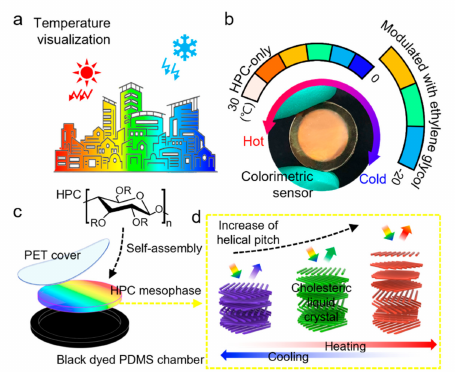
Figure 1. Sensor concept and design. ( a ) Illustration showing the concept and application of the HPC colorimetric temperature sensor. ( b ) Photograph showing the HPC colorimetric sensor and the sensing range. ( c ) Schematic image showing the materials comprising of the HPC colorimetric sensor. ( d ) Temperature-sensing principle of the HPC cholesteric liquid-crystal